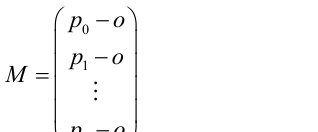
C++ and MATLAB. The experimental data of this paper is selected from the Airborne Lidar point cloud data on the Open Topography website. The website is a portal that provides high- resolution terrain data and operating tools. It can download LiDAR data from the United States, Canada, Australia and other places for